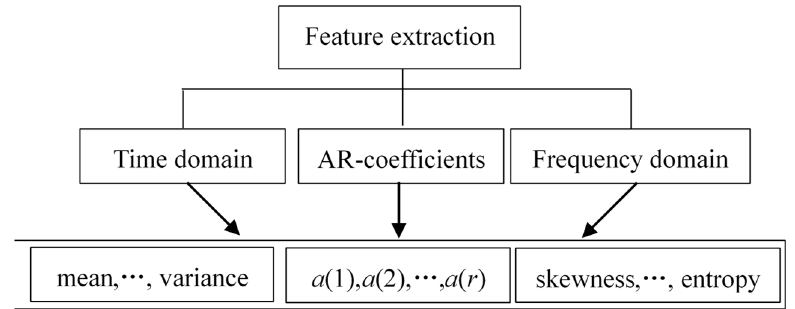
Figure 2. Block diagram for feature extraction in our activity recognition approach.